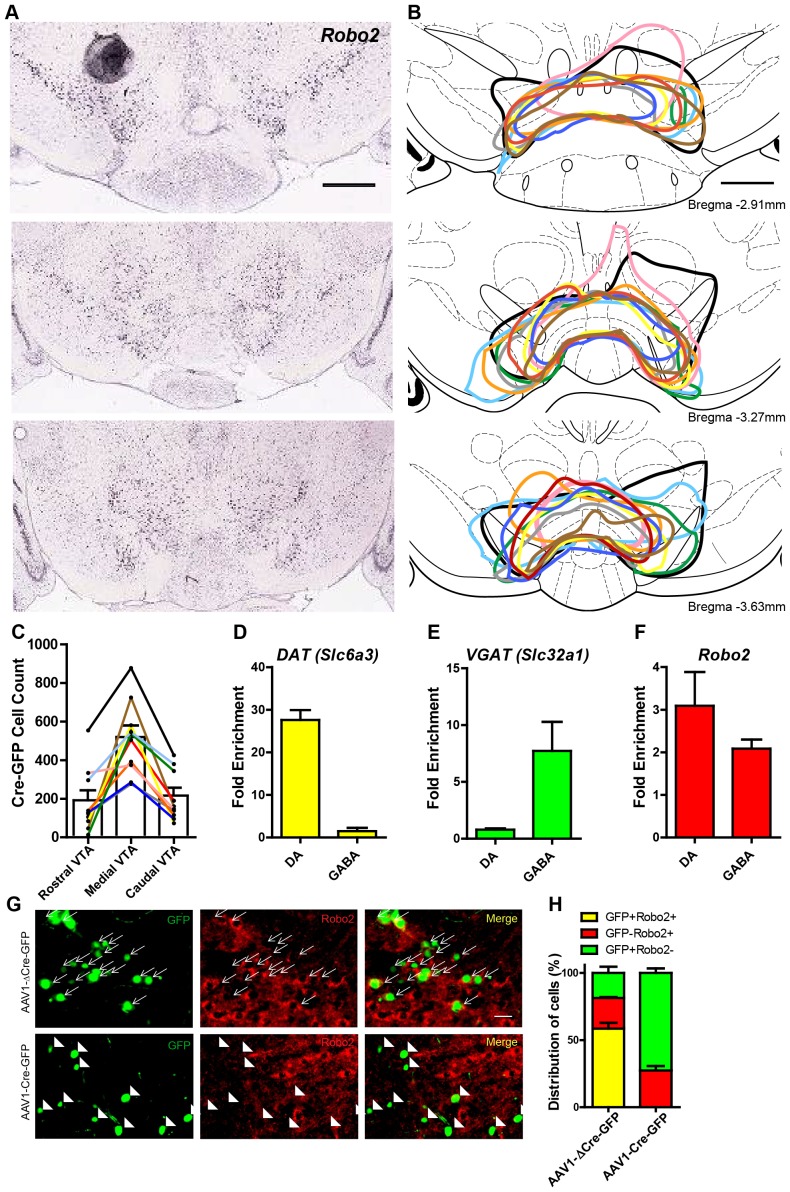
Robo2 VTA mutants.(A) In situ hybridization for Robo2 in the rostral, medial, and caudal VTA (image credit: Allen Institute). Scale bar = 500 µm. (B) Traces of the viral transduction of AAV1-Cre-GFP in Robo2lox/lox animals (n = 10) in the rostral, medial, and caudal VTA. Each color represents one animal and corresponds across the three sections and to the cell count quantification in (C). Scale bar = 500 µm. (C) Cell count of AAV1-Cre-GFP positive cells in the rostral, medial, and caudal VTA. (D) Slc6a3 (DAT) mRNA is enriched in midbrain dopamine (n = 3 animals) but not midbrain GABA neurons (n = 3 animals). (E) Slc32a1 (Vgat) mRNA is enriched in midbrain GABA but not midbrain dopamine neurons. (F) Robo2 mRNA is enriched in both midbrain dopamine and midbrain GABA neurons. (H) The distribution of cell types in Robo2lox/lox animals injected with either AAV1-∆Cre-GFP (n = 4) or AAV1-Cre-GFP (n = 4). Bars represent mean ± SEM. (G) Expression of the control virus, AAV1-∆Cre-GFP does not affect expression of Robo2 (arrows in top). AAV1-Cre-GFP causes loss of Robo2 in GFP+ cells of the VTA (arrowheads in bottom), but Robo2 expression is still expressed in GFP- cells. Scale bar = 10 µm.